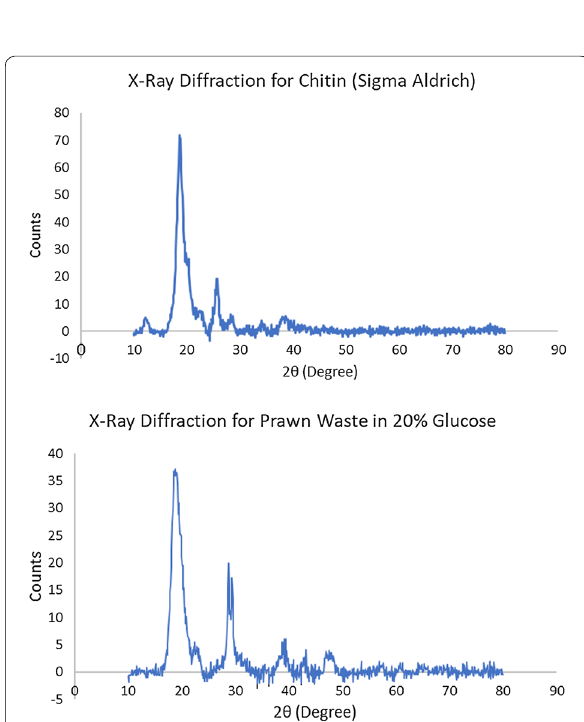
Fig. 4 X-ray diffraction pattern of commercial chitin and extracted chitin from glucose fermentation